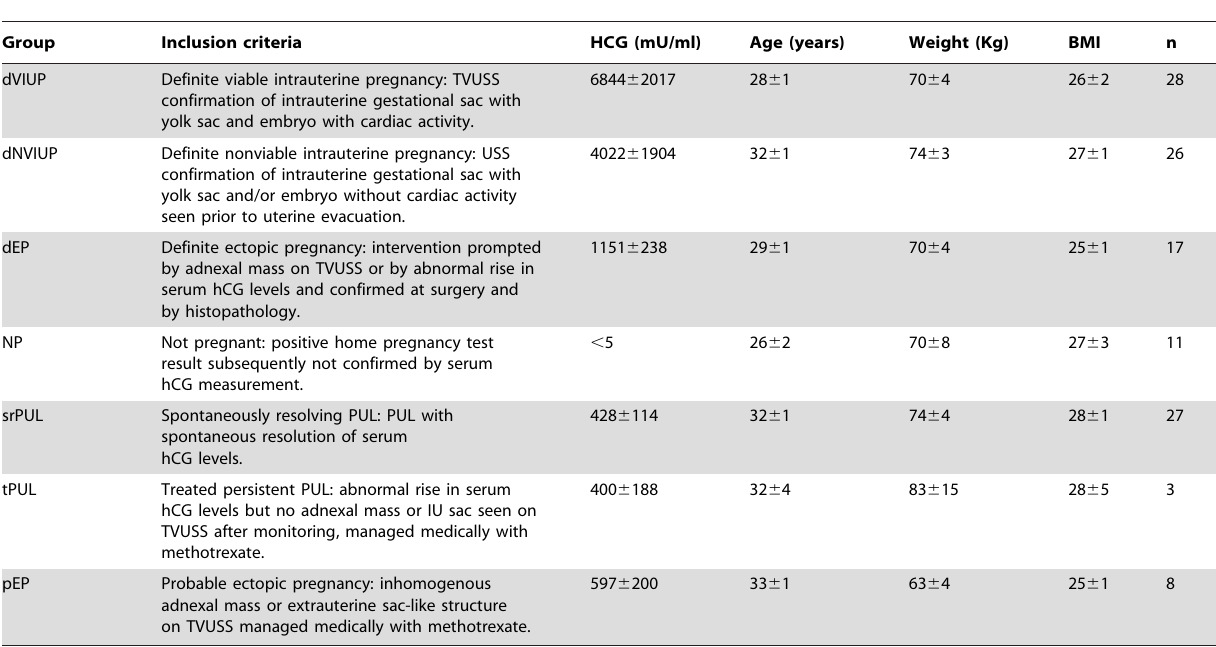
Table 1. Patient recruitment: 120 patients with an initial diagnosis of a PUL were recruited to the study and grouped according to final pregnancy outcomes.